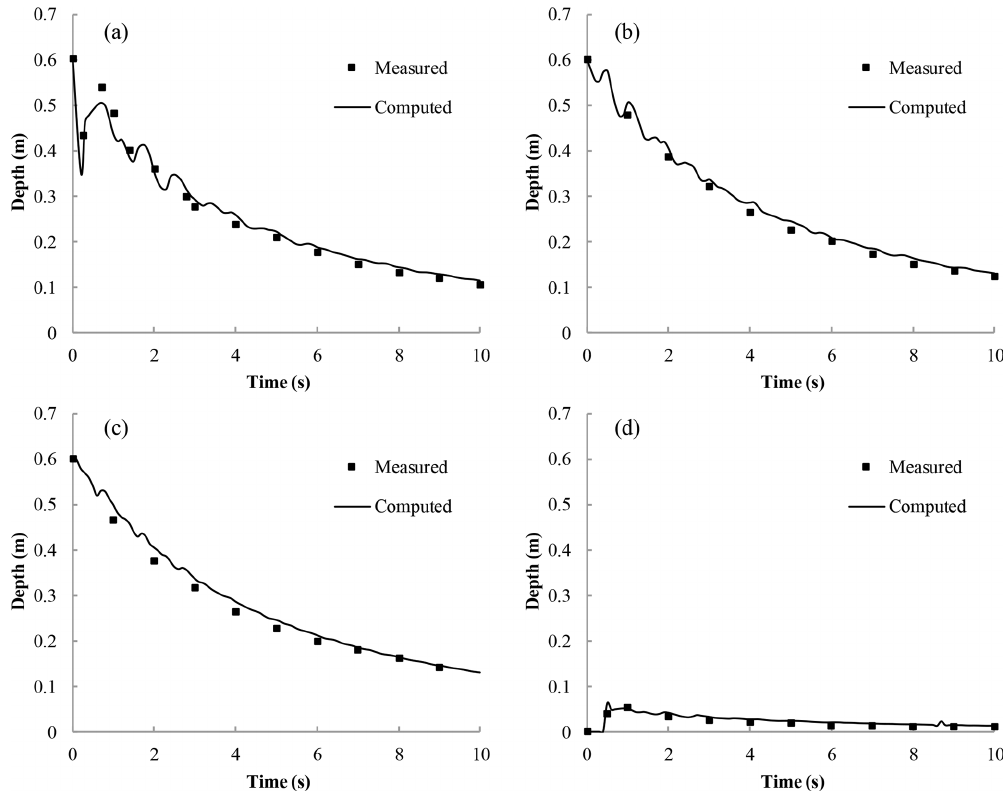
Figure 9. Comparison of water depth variation at four locations: (a) x = 1m, y = 1m; (b) x = 0 . 18m, y = 1m; (c) . x = 0 . 48m, y = 0 . 4m; (d) x = 1 . 802m, y = 1 . 45m.